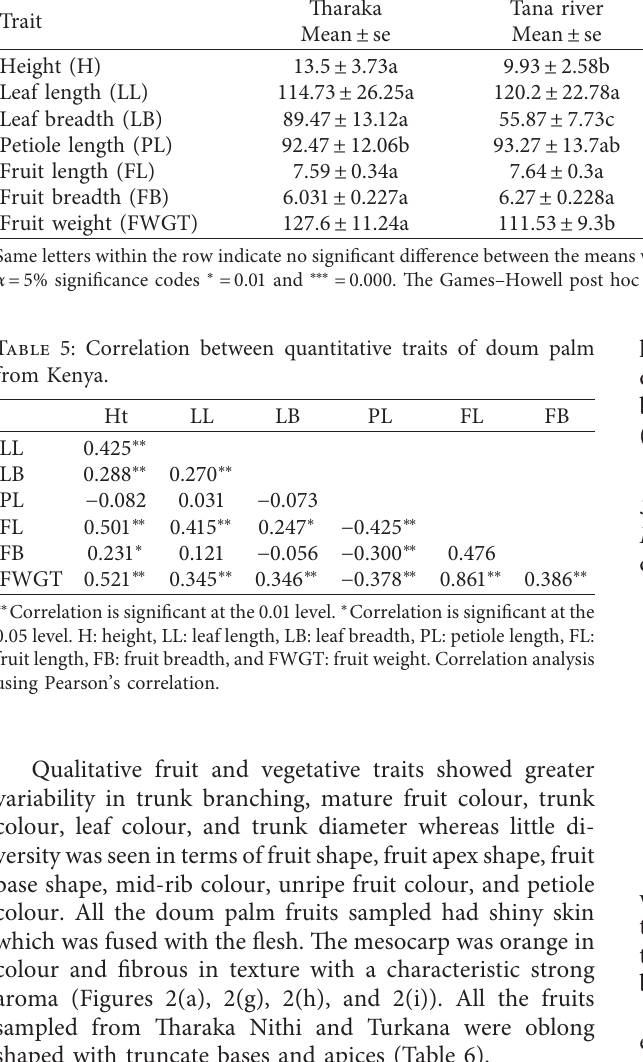
Table 4: Mean for quantitative traits of doum palm in sampled regions of Kenya. Trait